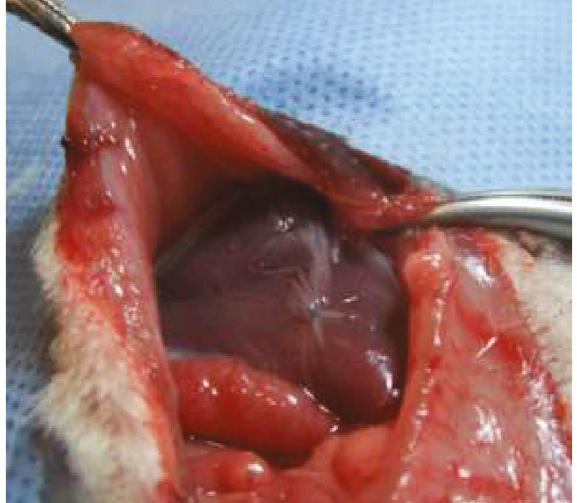
Figure 1: After the completion of bile duct ligature procedure, in the BDL+AM group, human amniotic membrane was sutured to the hepatic surface covering the whole